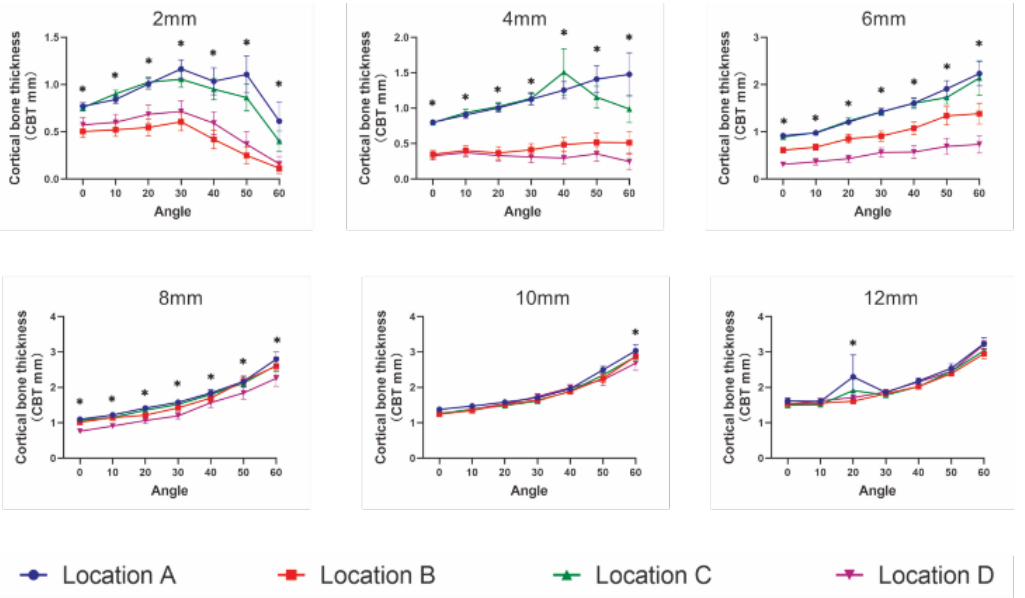
Figure 6. Comparison of the cortical bone thickness (CBT) among four insertion locations at each insertion height. * p < 0.05, statistical significance among four sites.